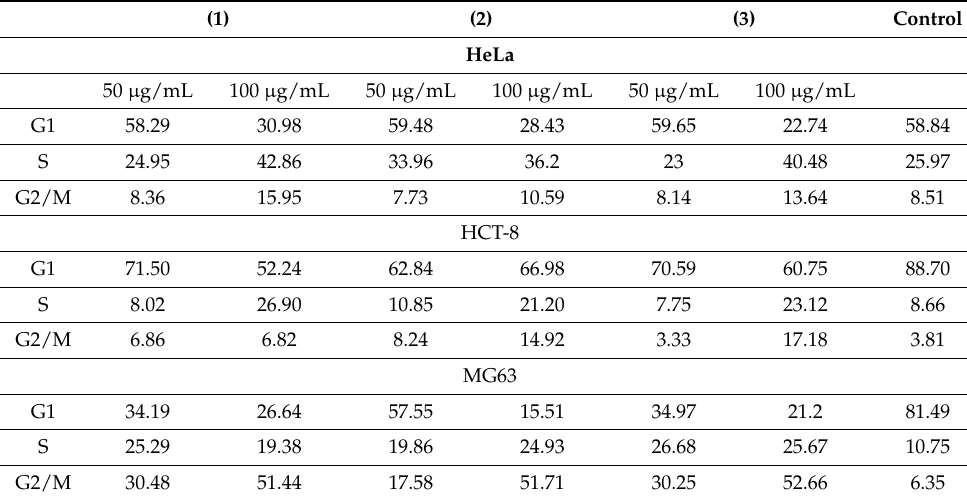
Table 7. Effect of co-imidazole compounds on cell cycle phases of HeLa, HCT-8, and MG63 cells. The results are presented as % of cells found in different stages of the cellular